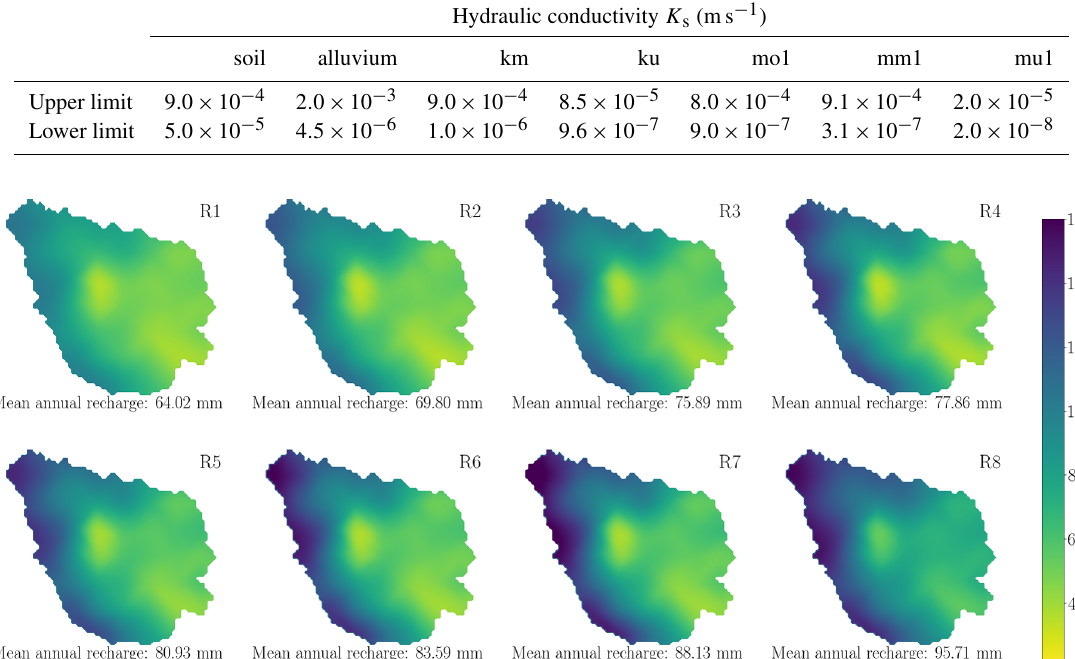
Table 1. Adjustable ranges of the hydraulic parameters.